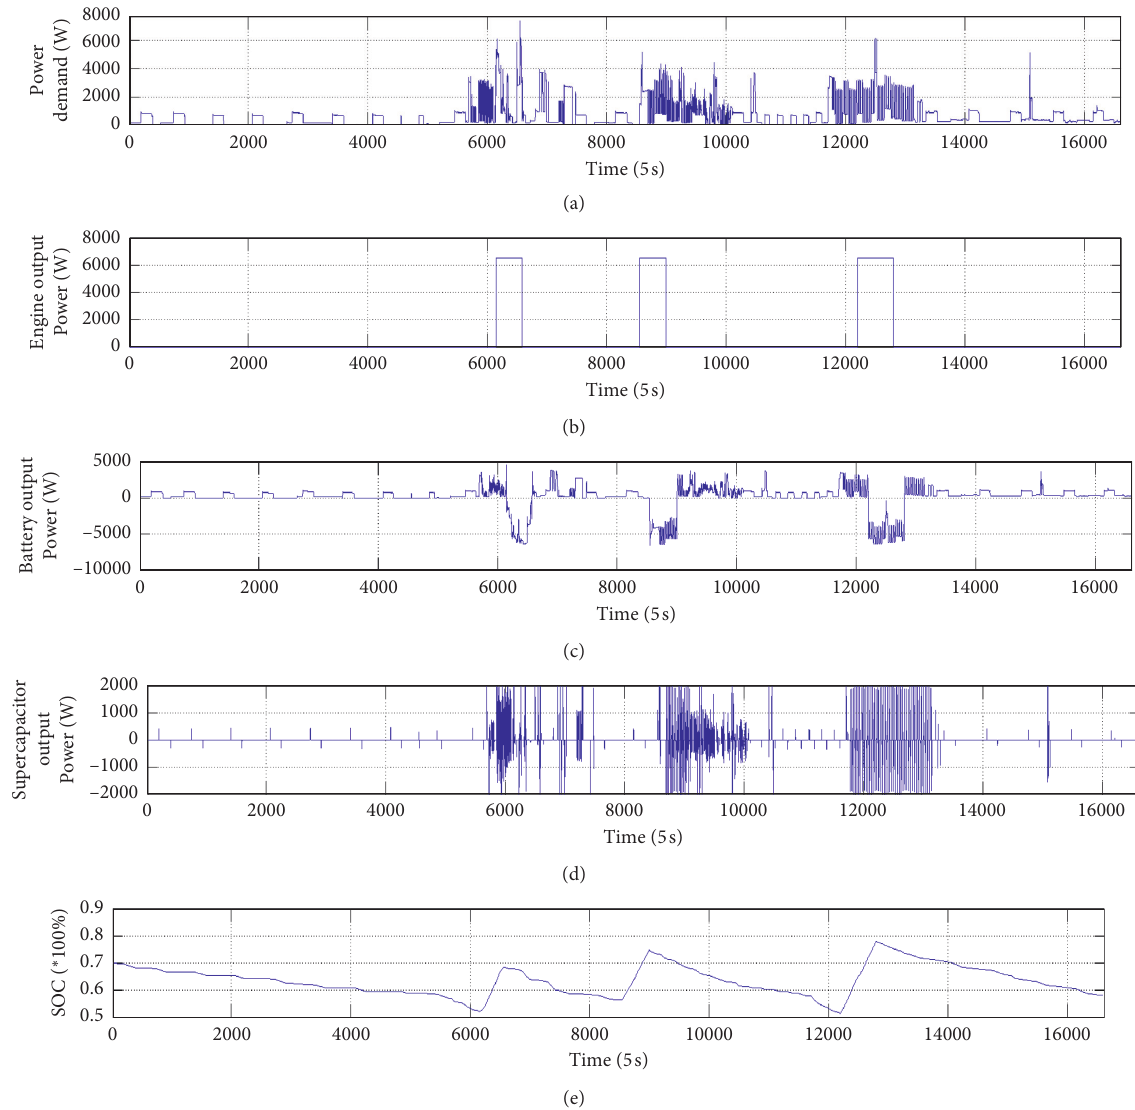
Figure 6: Five key parameters’ values are recorded during the operation of the integrated system with label A, B, C, D, and E. They are, respectively, power demand, engine out, batteries operation, supercapacitors operation, and batteries’ state of